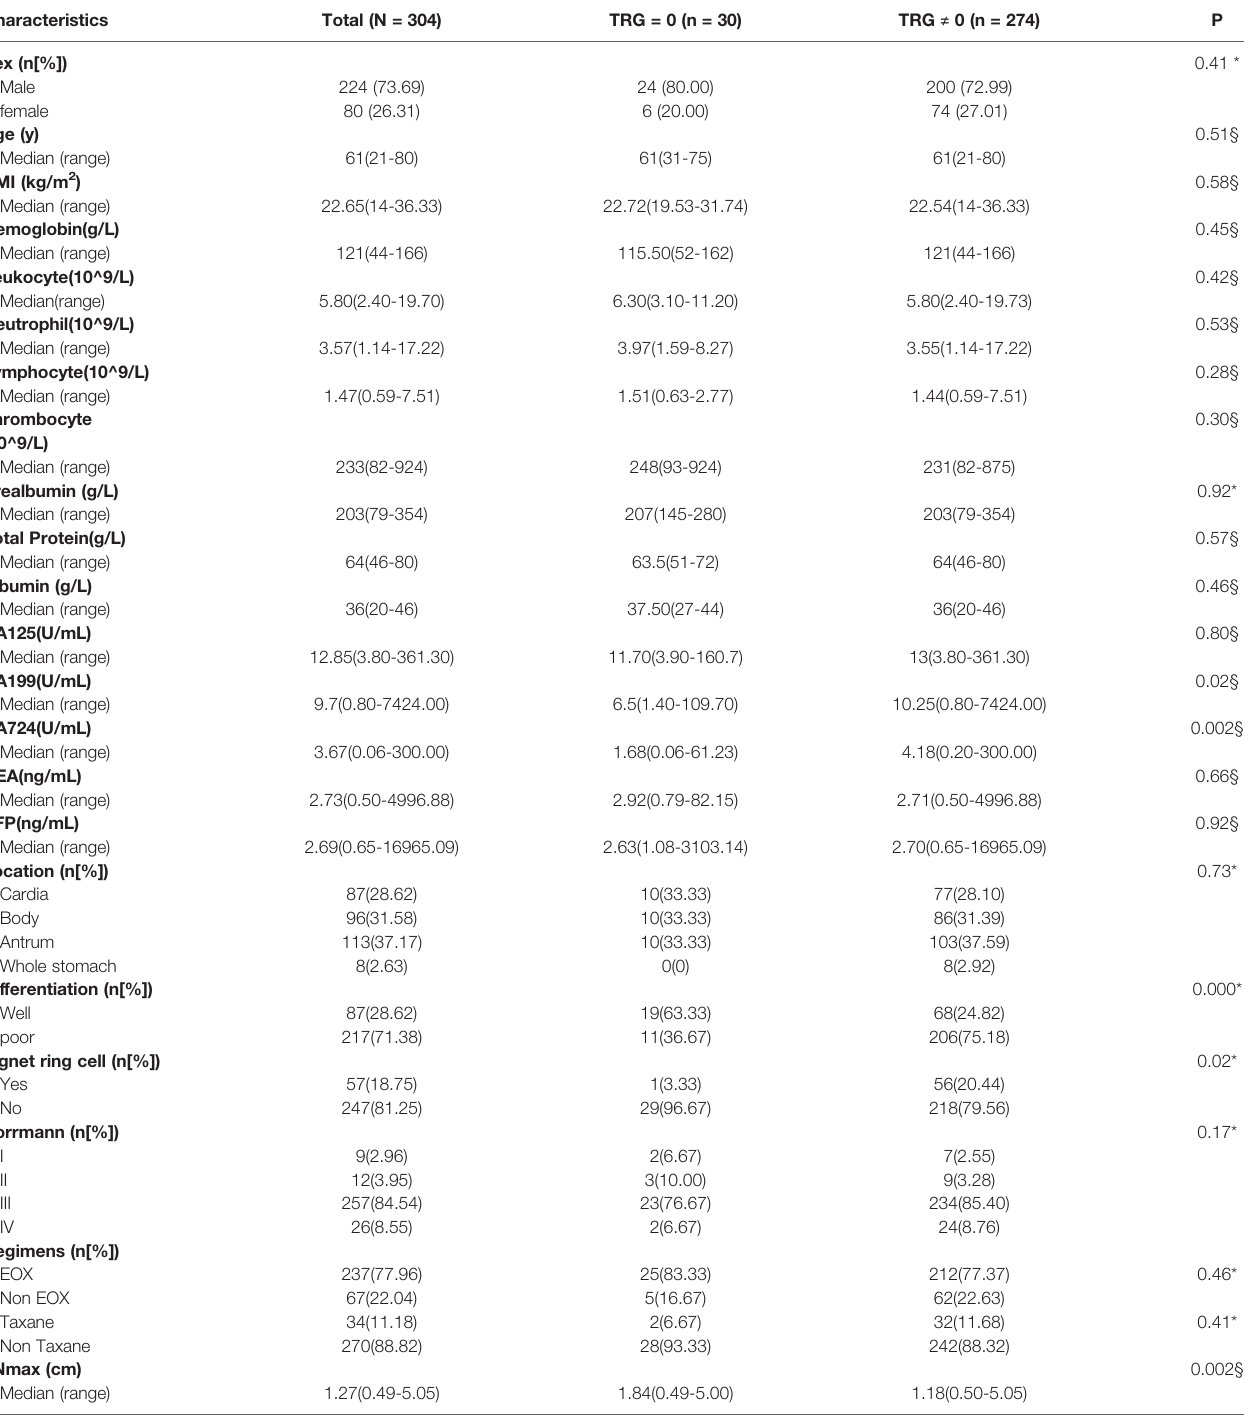
TABLE 1 | Univariate analysis: Characteristics of the Whole Study Population.